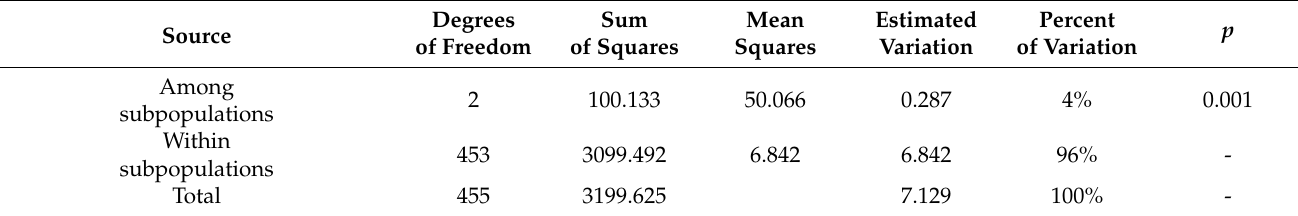
Table 4. Analysis of molecular variance.